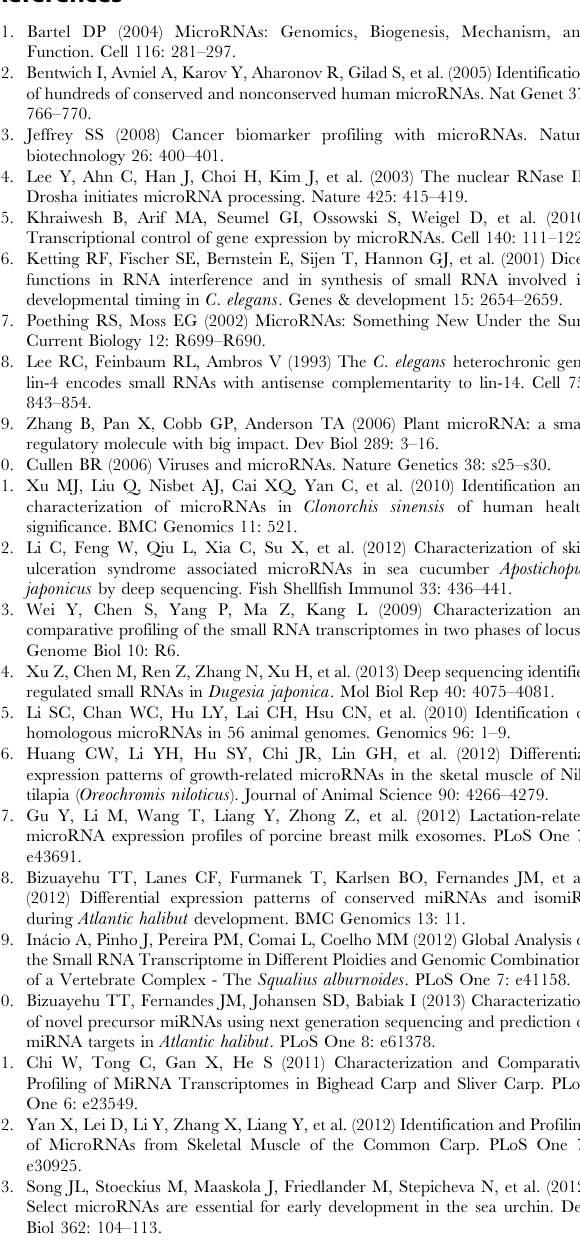
Figure S2 GO analysis result at level 2 for predicted target genes of miR-2005. (TIF) Figure S3 GO analysis result at level 2 for predicted target genes of miR-278-3p. Table S1 Conserved miRNAs identified from sea cu- cumber ( A. japonicus ) tube foot. Table S2 Prediction of miRNA target genes based on the transcriptome of sea cucumber ( A. japonicus ).